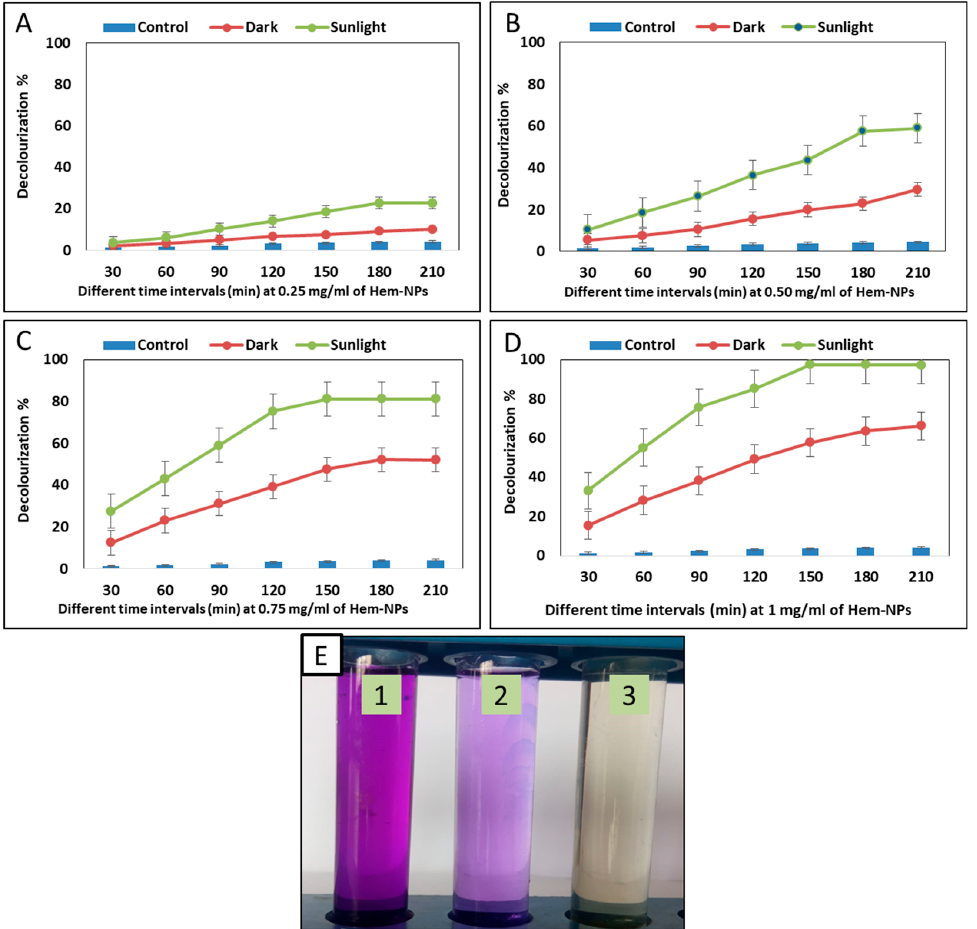
Figure 7. Decolorization percentages of crystal violet dye at different Hem-NPs concentrations, in different stimulation conditions (sunlight and dark), and for different contact times ( A – D ). Dye decolorization under sunlight and dark conditions ( E 1 – 3 ), where E1 was the dye control, E2 was the dye under the dark condition, and E3 was the dye under the sunlight